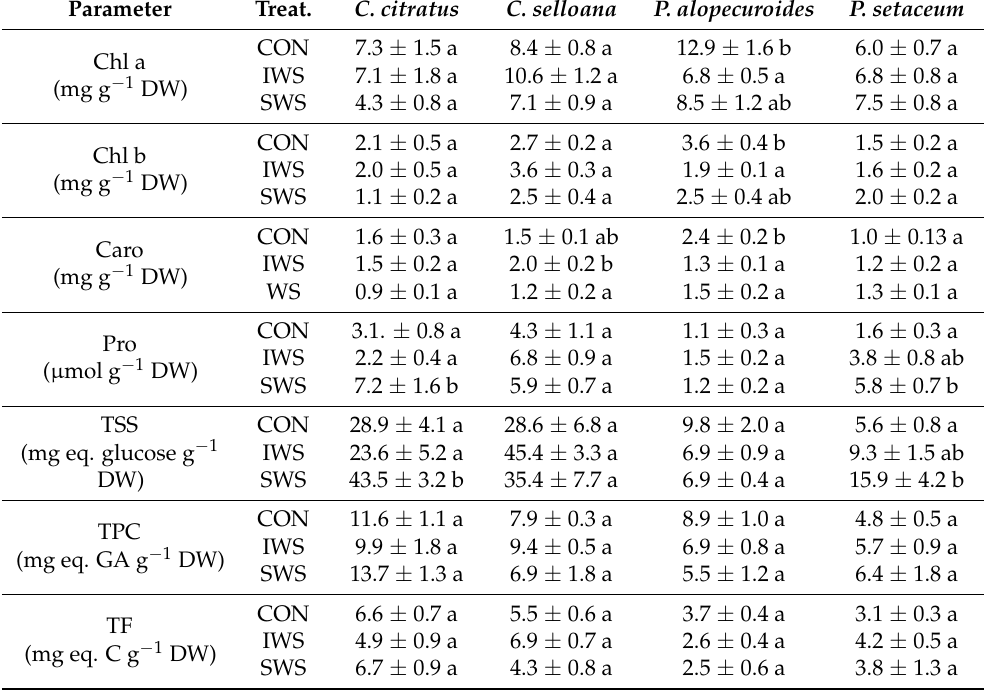
Table 4. Effect of stress treatments on the shoot contents of photosynthetic pigments, osmolytes and antioxidant compounds: chlorophylls a and b (Chl a and Chl b), carotenoids (Caro), proline (Pro), total soluble sugars (TSS), total phenolic compounds (TPC) and total flavonoids (TF). Values shown are means ± SE ( n = 5). Different lowercase letters indicate significant differences between treatments for each determined variable and species, according to the Tukey test ( p < 0.05). GA: gallic acid; C: catechin.